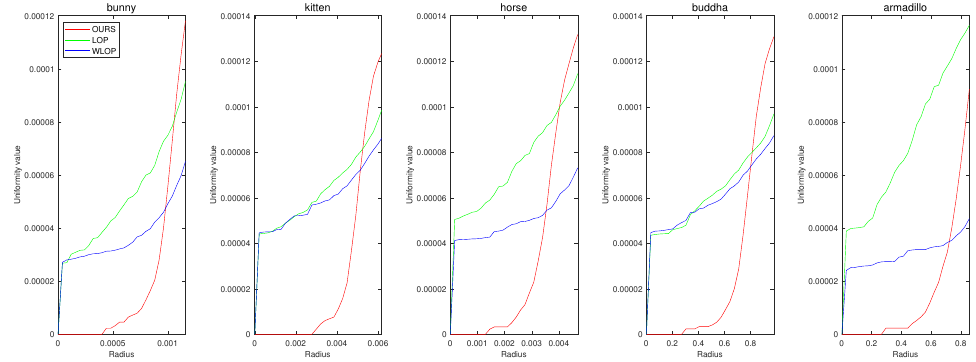
Figure 12. Quantitative results for the omnidirectional noise cases with resampling ratio 0.5. Each column represents different input data (first column: Horse; second column: Bunny; third column: Kitten; fourth column: Buddha; and fifth column: